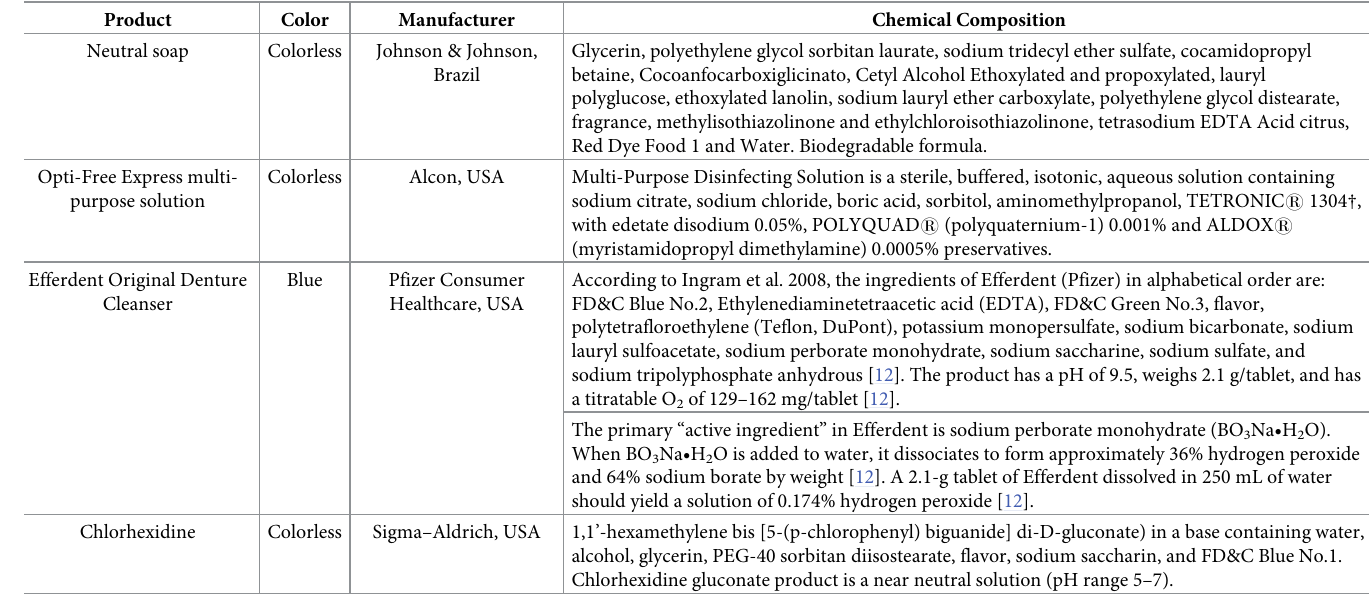
Table 1. Disinfectants used in this